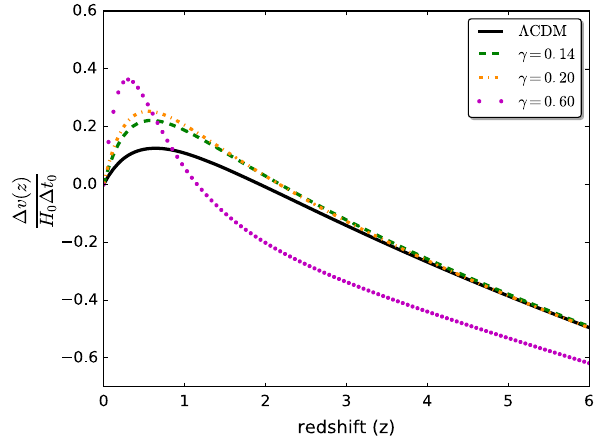
Fig. 11 The dimensionless redshift drift for various values of the vis- cosity of the viscous dark energy model. At the early time, the value of this parameter is more than the standard model due to contribution of the viscosity. In this plot we assume that c = 1